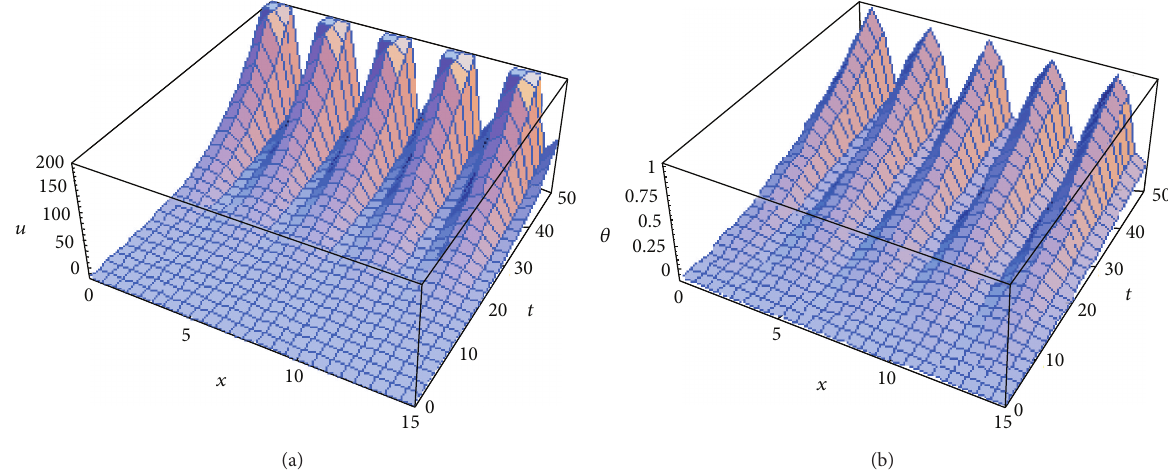
Figure 8: Variations of the displacement 𝑢 and the temperature 𝜃 for various values of the 𝑥 -axis and time 𝑡 when Ω = 𝜎 1 = 𝜎 2 = 0 , 𝜏 2 = 0.2 , = 0.1 , 𝛿 = 0 , and 𝜔 = 0.02 . 𝜏 1